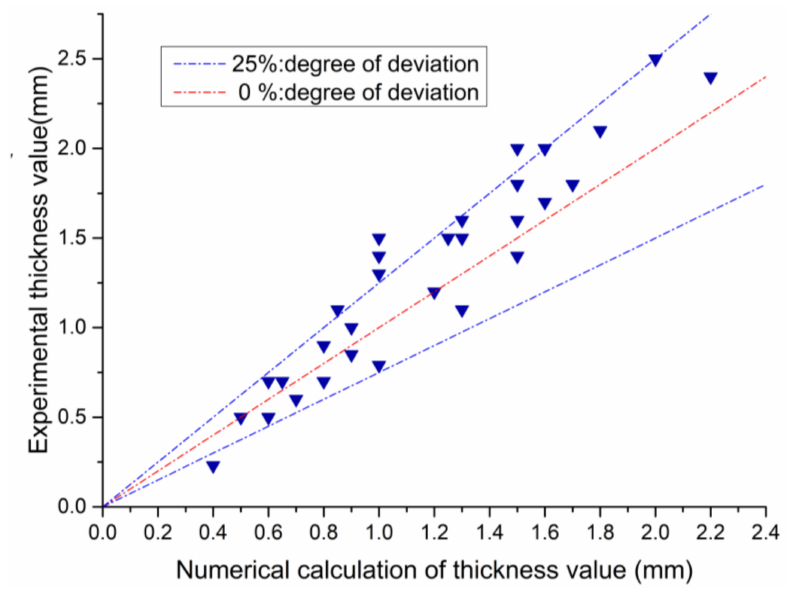
Figure 5. Frost layer thickness verification